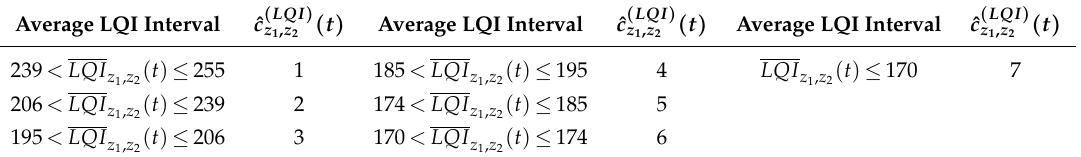
( t ) ), and the estimated link cost ˆ c ( LQI ) 1 , z 2